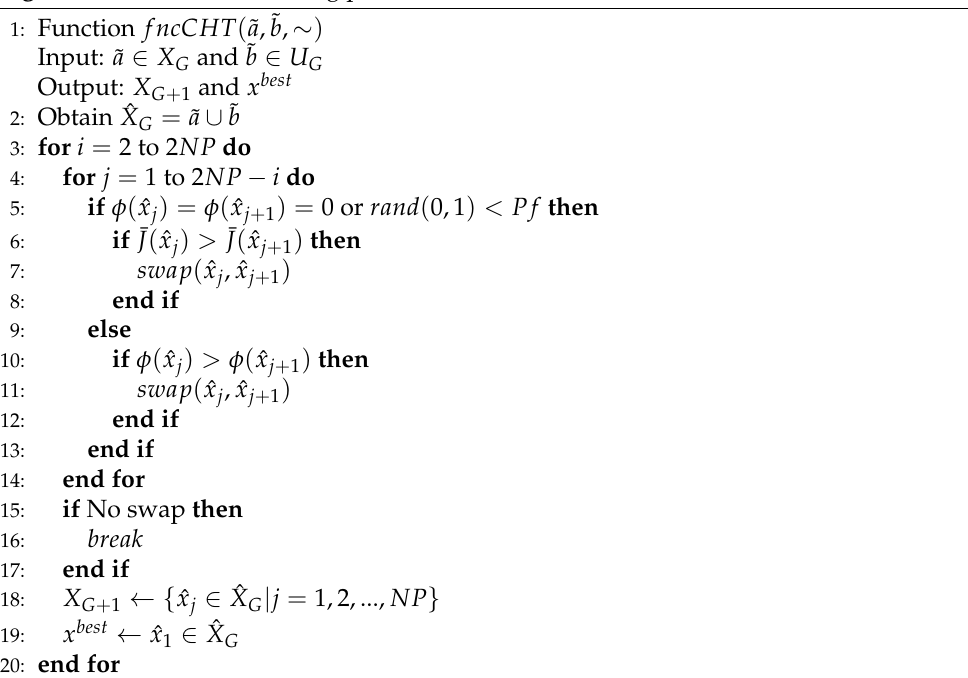
Algorithm 7 Stochastic ranking